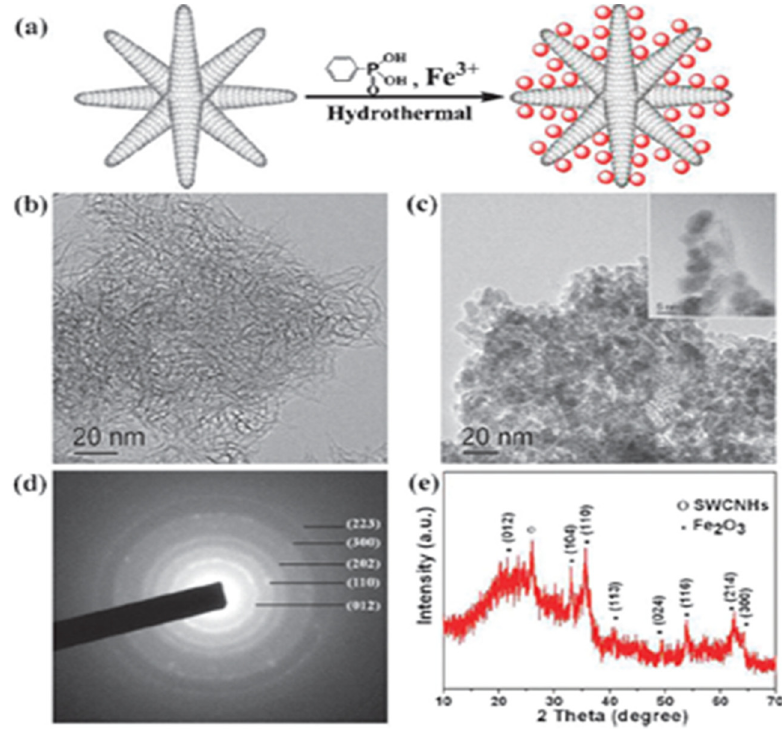
Figure 7. ( a ) Schematic synthesis of Fe 2 O 3 /SWCNHs composite; ( b ) TEM image of SWCNHs. ( c ) TEM image of Fe 2 O 3 /SWCNHs composite inset shows the HRTEM picture of Fe 2 O 3 particles decorated on the wall of SWCNHs; ( d ) and ( e ) are the corresponding selected area electron diffraction and XRD pattern of Fe 2 O 3 /SWCNHs composite. Reproduced with permission of [62]; Royal Society of Chemistry,